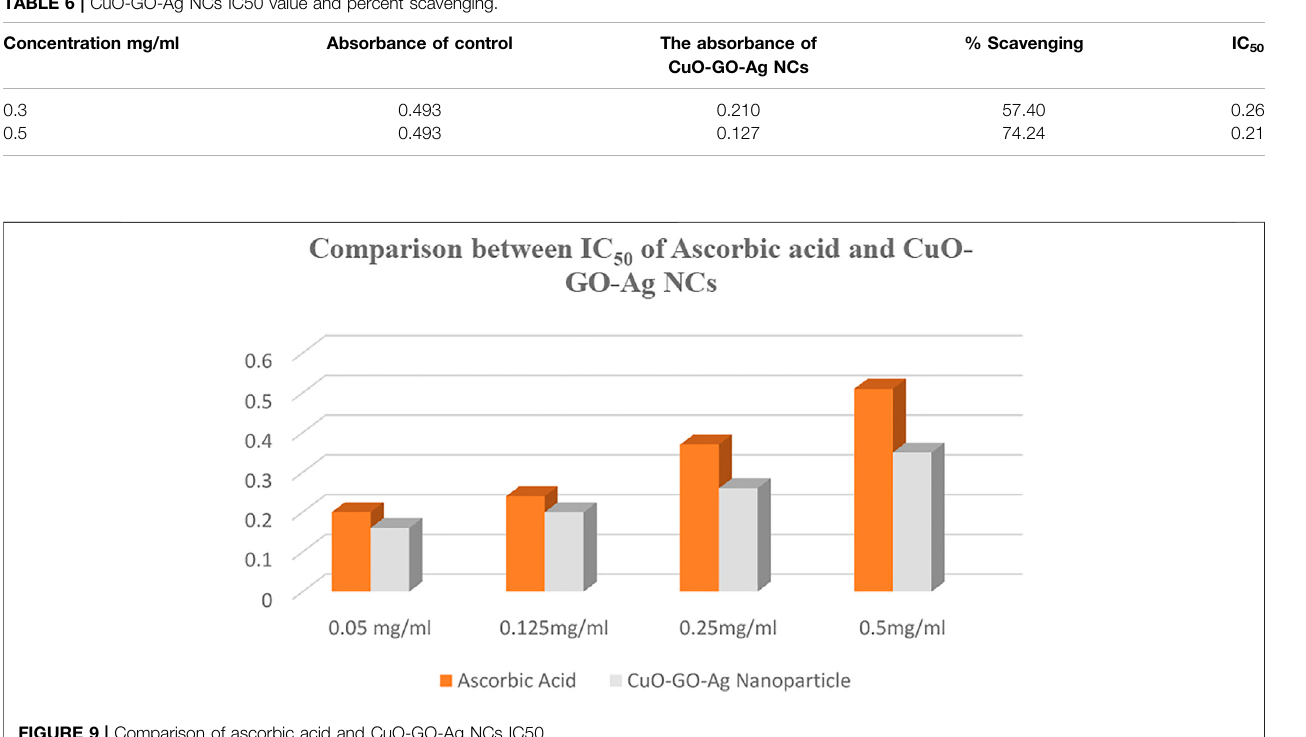
FIGURE 9 | Comparison of ascorbic acid and CuO-GO-Ag NCs